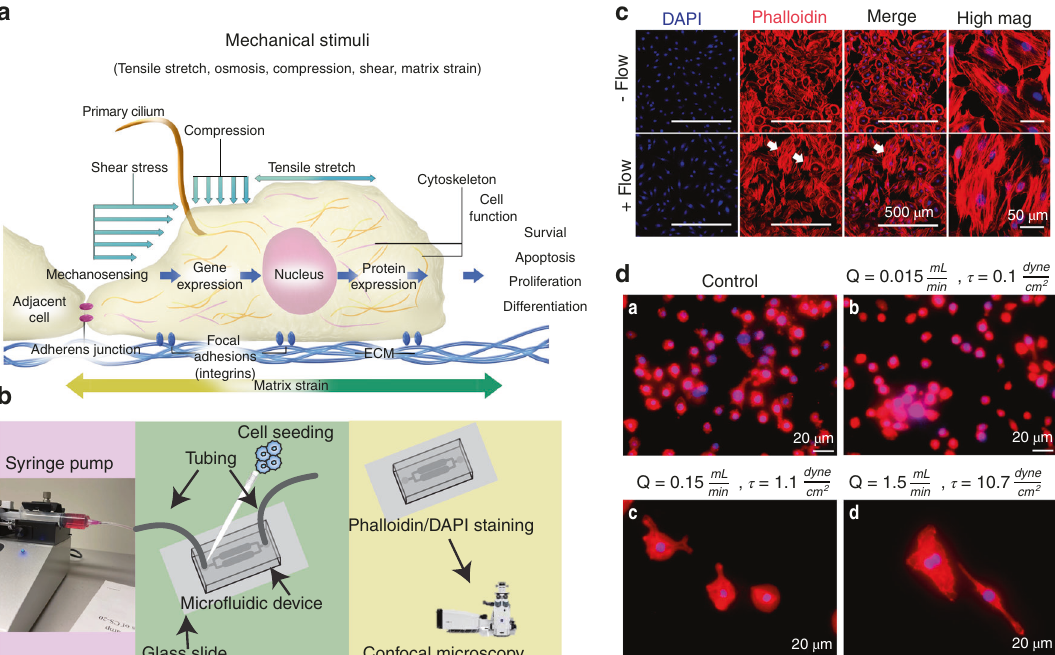
Fig. 3 Gravity and external mechanical stimuli in fl uence the growth, development, and maintenance of healthy tissues. a Cells sense their mechanical environment (e.g., tensile stretch, compressive strains, and shear stimuli) via mechanisms involving cilia, adherens junctions, ion channels, and focal adhesion. b The controlled fl uid environment provided by 2D micro fl uidic devices is a commonly used method to examine the cell response under different fl ows. c Representative micrographs of IDG-SW3 murine late osteoblasts/preosteocytes taken using confocal microscopy showing cell nuclei (DAPI (blue)) and F-actin cytoskeletal fi laments [phalloidin (red)]. Cells were cultured within a micro fl uidic device. A fl ow rate of 0.15 mL·s − 1 was applied, and the mechanosensitive actin fi laments responded by realigning their structure, becoming more parallel in orientation (white arrows). Images show the fl uid-induced response after 24 h of culture. d Representative micrographs of macrophages within micro fl uidic devices (24 h) and examined using fl uorescence microscopy (×20 mag.). Images show red cytoplasmic actin fi laments (phalloidin) and blue nuclei (DAPI). a Static- fl ow conditions and following the application of continuous fl uid fl ow delivered at b 0.1 dyn per cm 2 , c 1.1 dyn per cm 2 and d 10.7 dyn per cm 2 (physiological) fl uid shear to cells. The cells were observed to respond differently to changes in fl uid shear. M0 (nonactivated) macrophages are characterized by their small size (~10 µm) and abundant number, and this phenotype is indicated in the unstimulated static control group. Following the application of an extremely low fl uid shear (0.1 dyn per cm 2 ), the cells were fewer in number and slightly larger (~15 – 20 µm), displaying a more M1-like, proin fl ammatory, osteodestructive phenotype. Notably, there were fewer nuclei, suggesting cell death. Remarkably, when exposed to higher shear rates, the cells become much larger (~80 – 100 µm) and are round or spindle shaped, suggesting an osteoprotective M2 The role of the cytoskeleton The mechanical aspects of cell life are central for cell motility, cell division, intracellular transport, and positioning of organelles, to name a few relevant phenomena. 48 Therefore, gravity and external mechanical stimuli, including tensile and compressive stresses, fl uid-exerted shear, and hydrostatic pressure, all greatly in fl uence the growth, development, and maintenance of healthy tissues and cells. 49 The cellular response to these forces can be described by 3 sequential events: mechanosensing involves the cell sensing changes in its local mechanical environment through changes to the cytoskeletal architecture; mechanotransduction involves the conversion of force- or geometry-induced changes into biochemical signals; and the mechanoresponse can be short- and/or long-term. Short-term responses include alterations to cell motility systems responsible for migration and surface adher- ence. 50 Long-term responses include modi fi cations to the cell leading to altered cell survival or new deposition/remodeling of extracellular matrix. 51 The overarching term “ mechanotransduc- tion ” refers to the set of mechanisms that enables the cell to convert a mechanical stimulus into biochemical activity. All osteogenic cells, from MSCs to osteoblasts to osteocytes, are mechanosensitive and therefore can sense and respond to applied force. 52 The cell cytoplasm is not a simple liquid. The cell is a mechanical machine, and continuum mechanics of the fl uid cytoplasm and